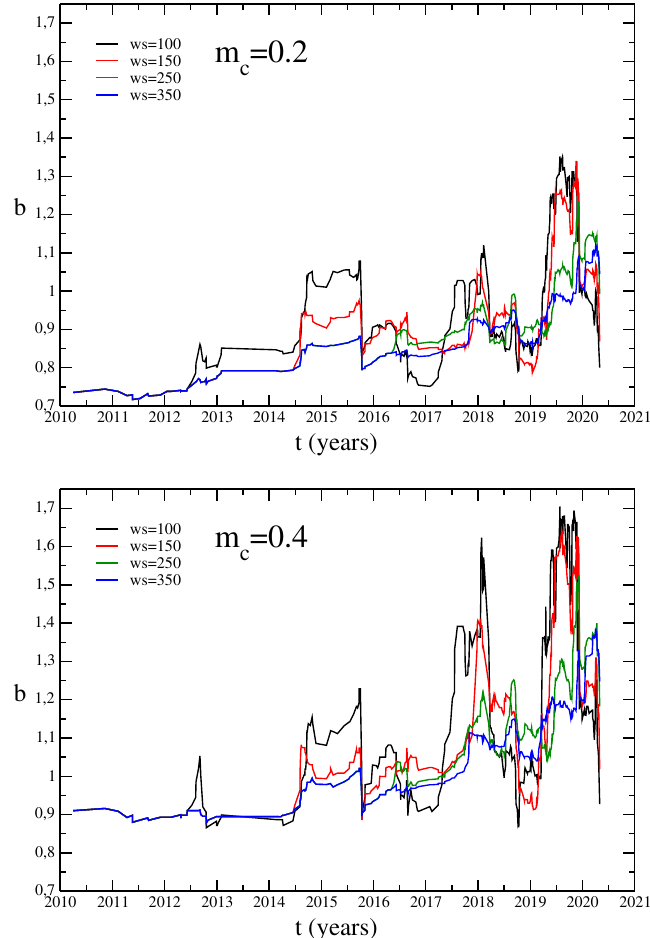
Figure 3. Temporal variations of the b value for different window size and M c values.